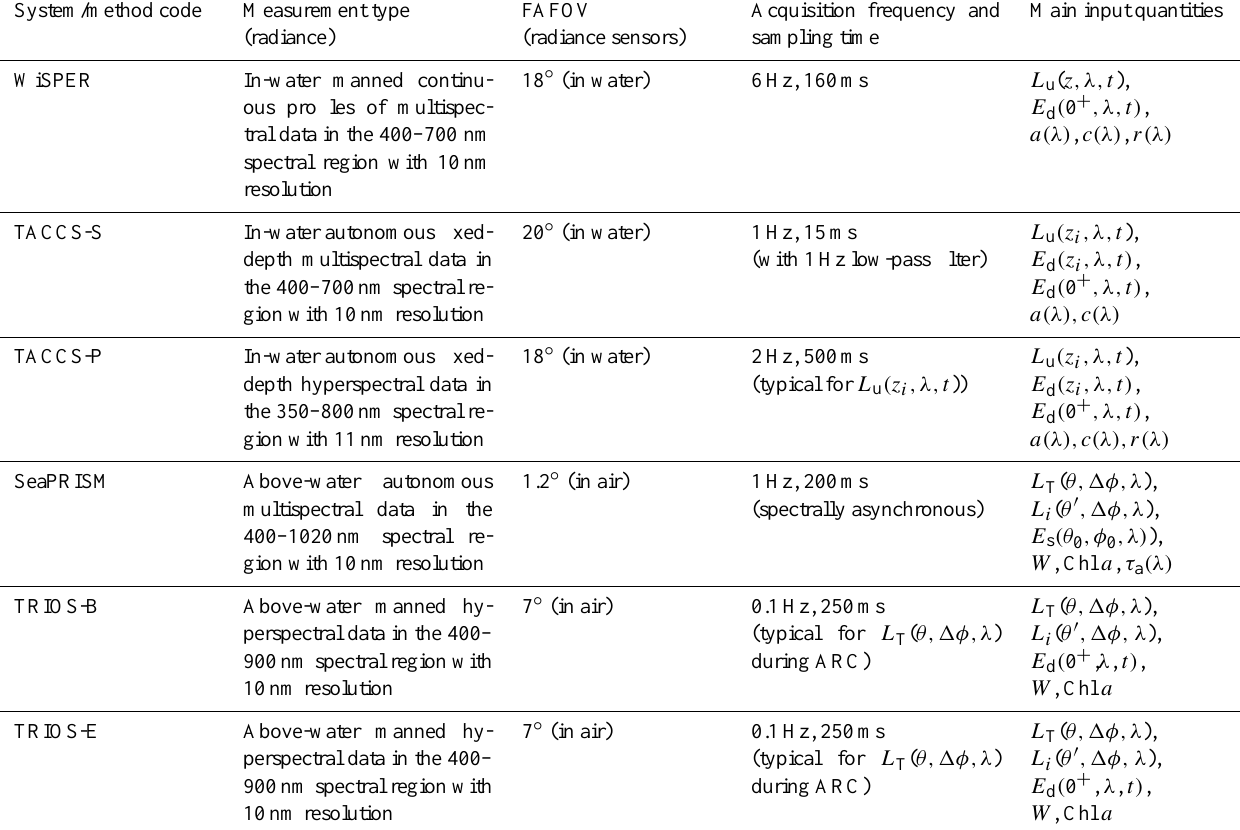
Table 2. Summary of ARC systems/methods details and of main input quantities required for data processing (symbols r , a and c indicate the above-water diffuse to direct irradiance ratio, the seawater absorption and beam attenuation coefficients, respectively).